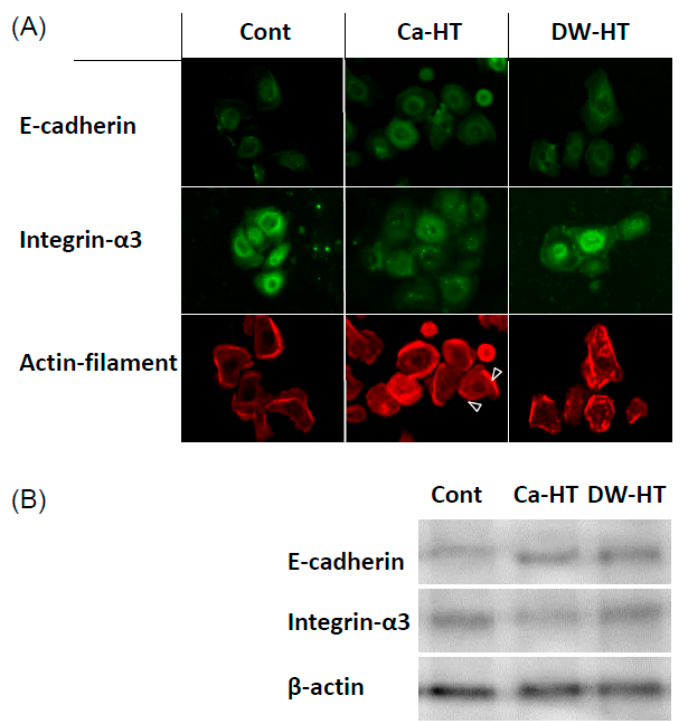
Figure 8. ( A ) Localization of cell migration-related proteins in OECs. Cells seeded onto Ca-HT represented well-organized actin ring. Numerous and punctate immune-reactivity of In- α 3 was present throughout the OEC cytoplasm in the Cont and DW-HT groups. The Cont group had a similar distribution of E-cadherin in cells to both the Ca-HT and DW-HT groups. ( B ) Western blot analysis of adhesion proteins. Expression levels of In- α 3 in the cells grown on the Ca-HT group were slightly lower compared with the Cont and DW-HT groups.